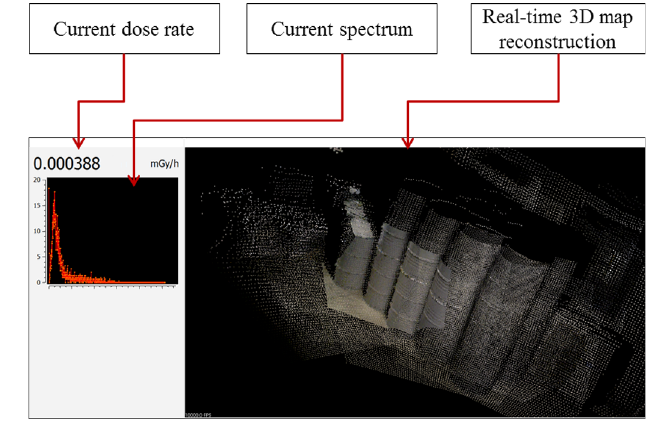
Fig. 5. Acquisition interface.